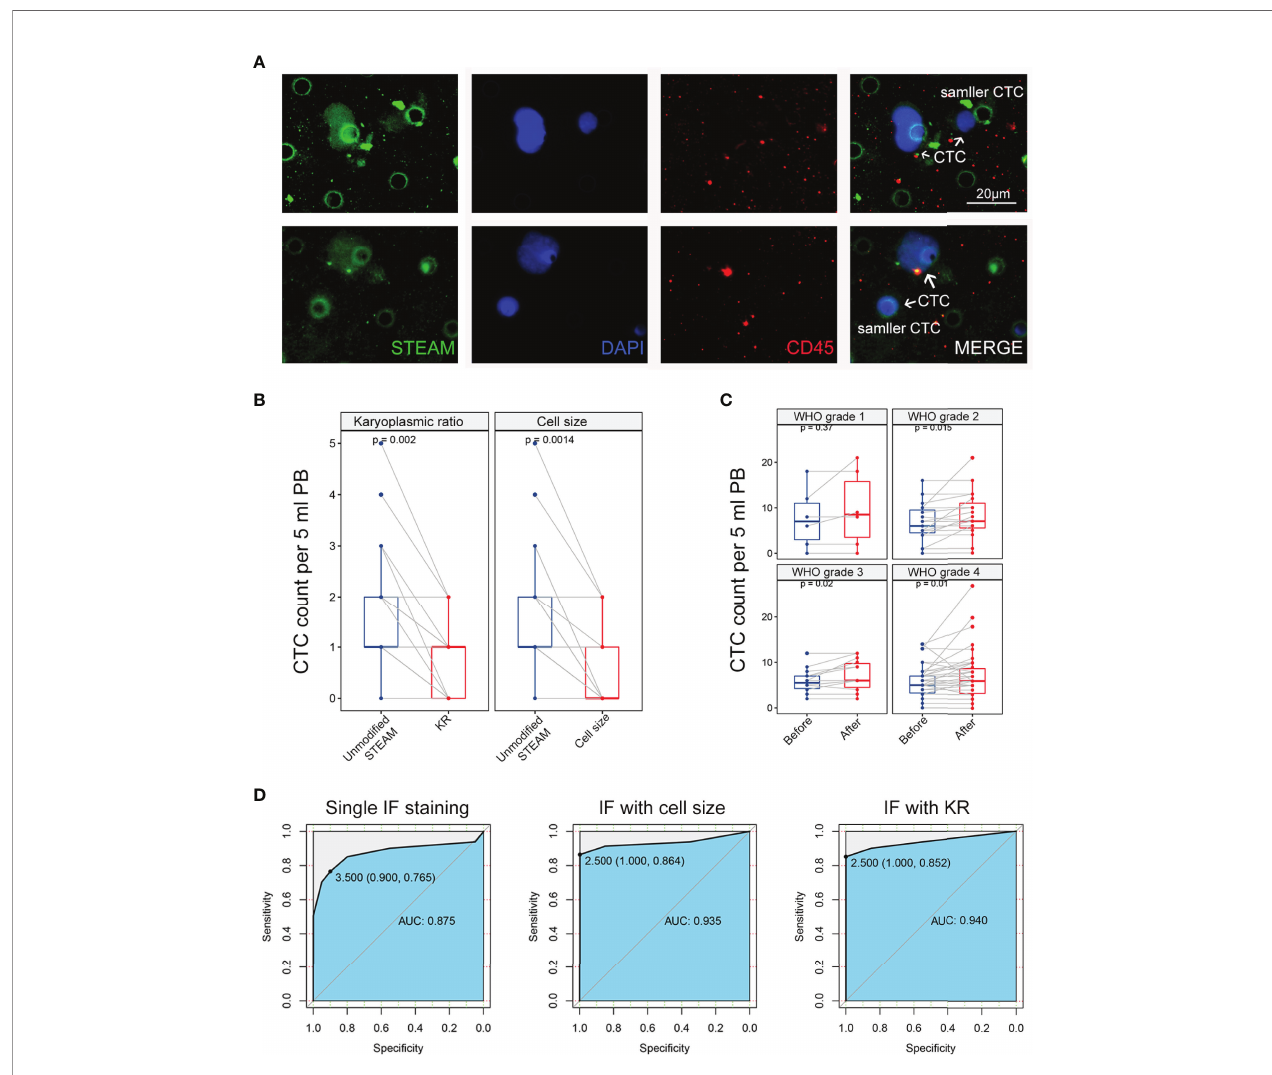
FIGURE 2 | Comparing identi fi cation effect of methods based on karyoplasmic ratio and cell size in clinical samples. (A) The representative IF image of CTC in glioma, containing CTC with normal size and smaller size. Scale bar = 20 m m. (B) Left panel: method based on karyoplasmic ratio decreased the background level and false-positive risk in healthy donors ( p = 0.002). Right panel: method based on cell size also decreased the background level and false-positive risk in healthy donors ( p = 0.0014). (C) Compared with the method based on cell size (blue), the method based on karyoplasmic ratio signi fi cantly increased detectable level of CTC in glioma with WHO grade 2-4 ( p = 0.015, p = 0.02, and p = 0.01, respectively). Before: method with cell size; after: method with KR. (D) Left panel: ROC curve for single IF staining in glioma diagnosis (AUC = 0.875). Middle panel: ROC curve for IF staining with cell size in glioma diagnosis (AUC = 0.940). Right panel: ROC curve for IF staining with KR in glioma diagnosis (AUC =